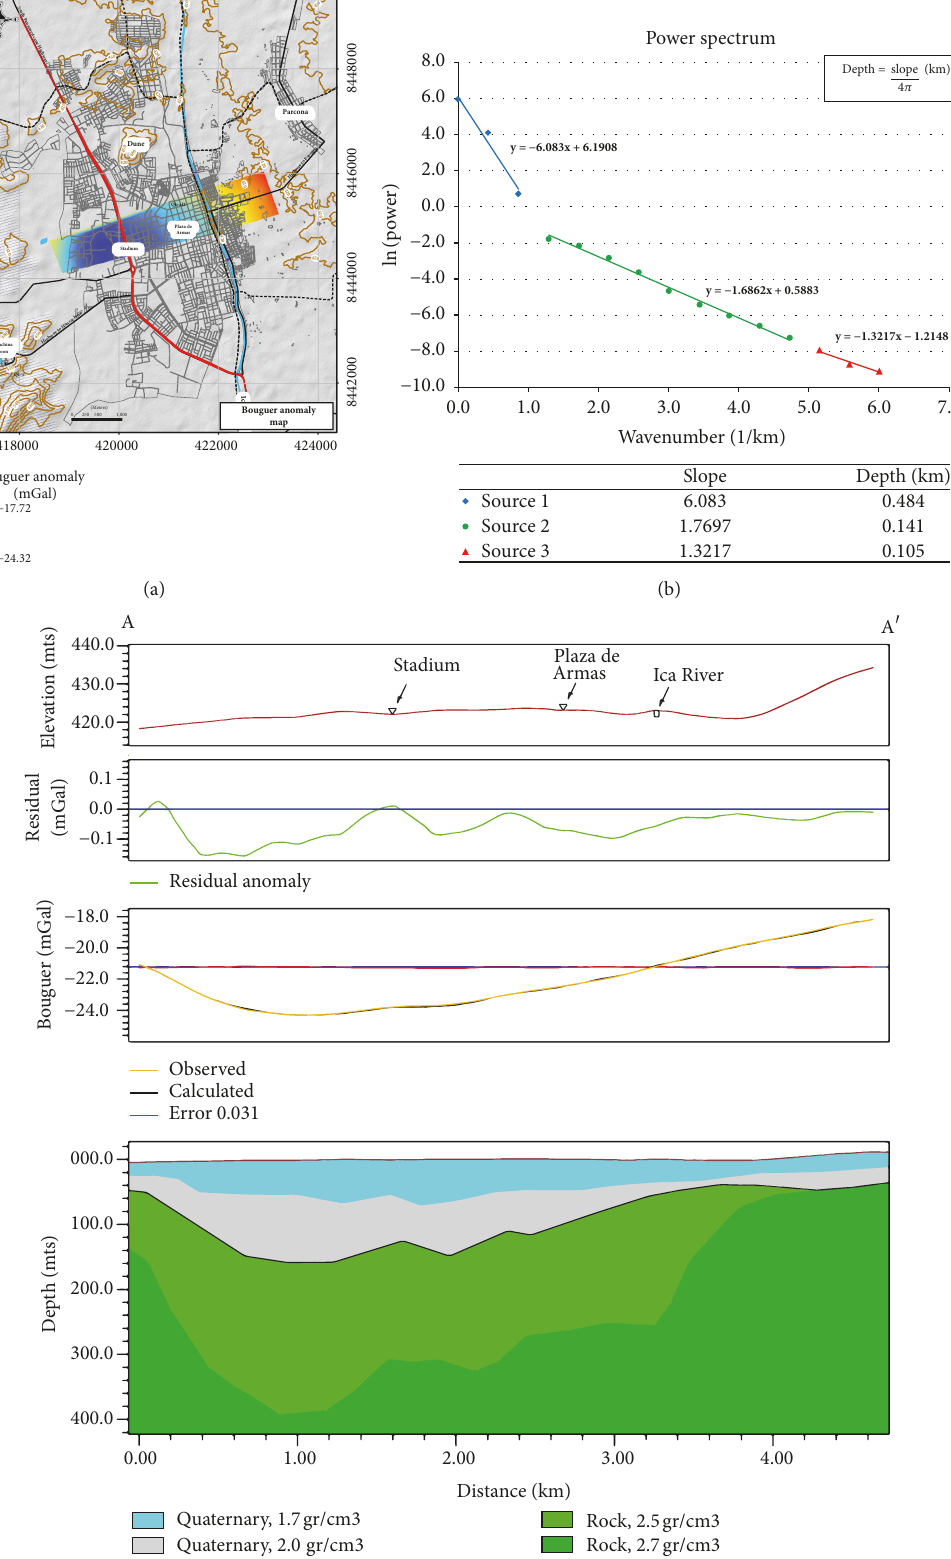
(see Figure 1) showing sedimentary deposits and the rocky